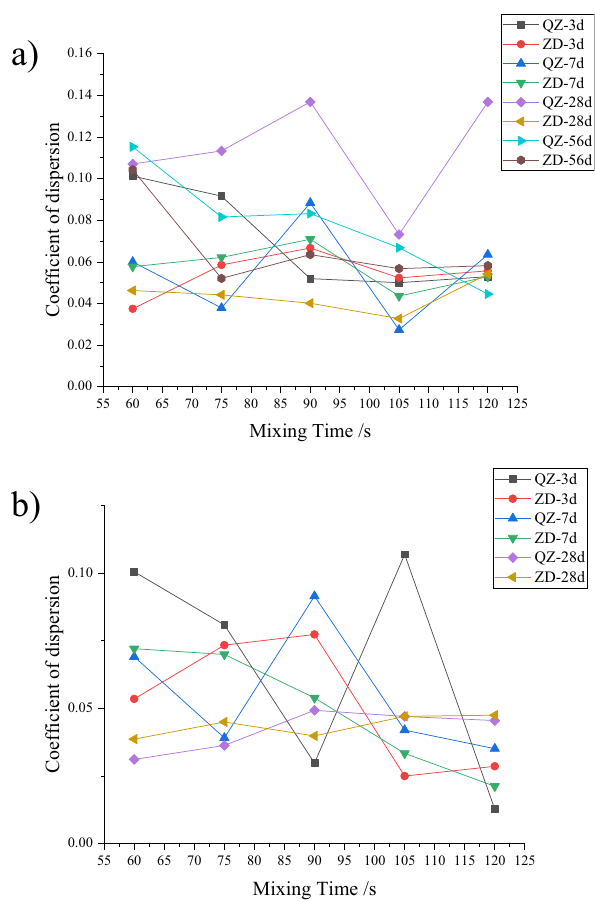
Figure 6: The in fl uence of age and mixing time on the dispersion coe ffi cient of concrete compressive strength: ( a ) C40 dispersion coe ffi cient variation curve with time and ( b ) C60 dispersion coe ffi - cient variation curve with